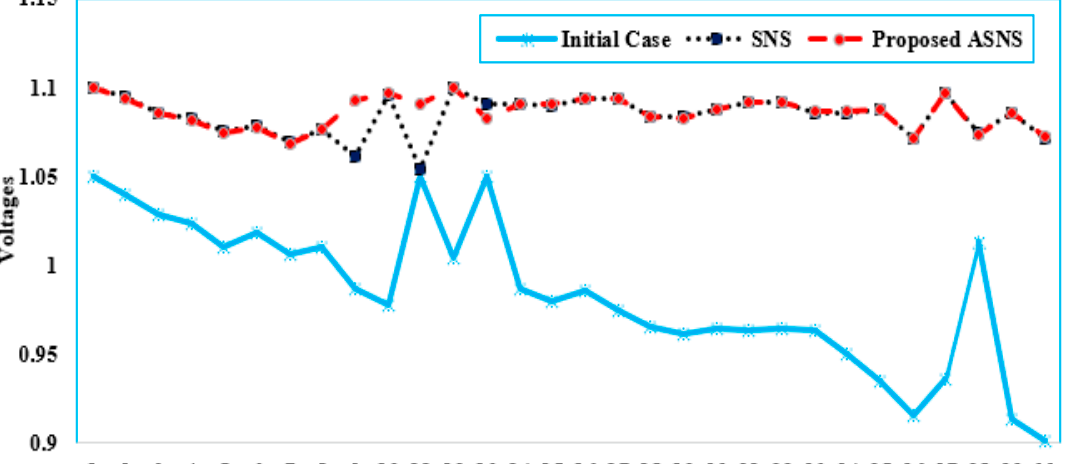
Figure 3. Convergence features of the ASNS and SNS for Case 1 of the IEEE 30-bus grid.